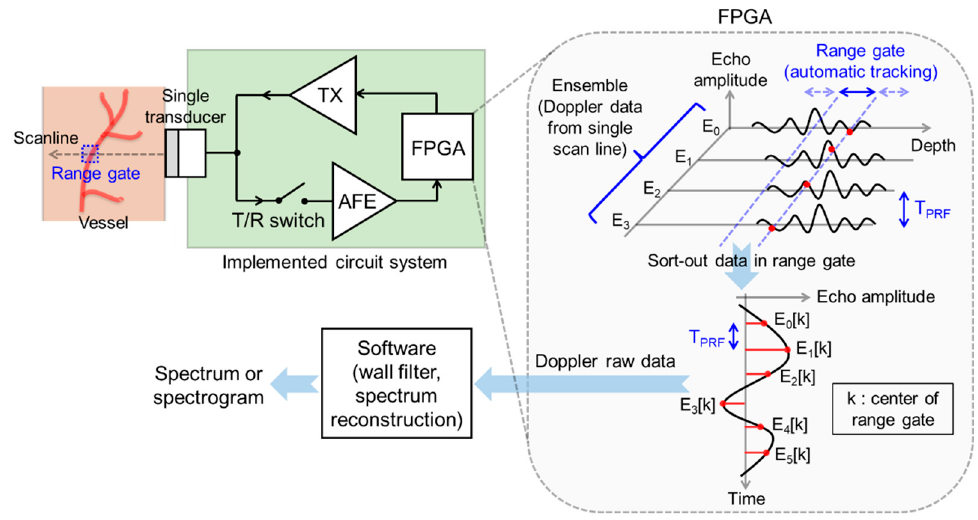
Figure 2. Proposed image-free ultrasound blood-flow-monitoring circuit system; TX: transmitter; AFE: analog front-end; FPGA: field-programmable gate array; RF: radio frequency.